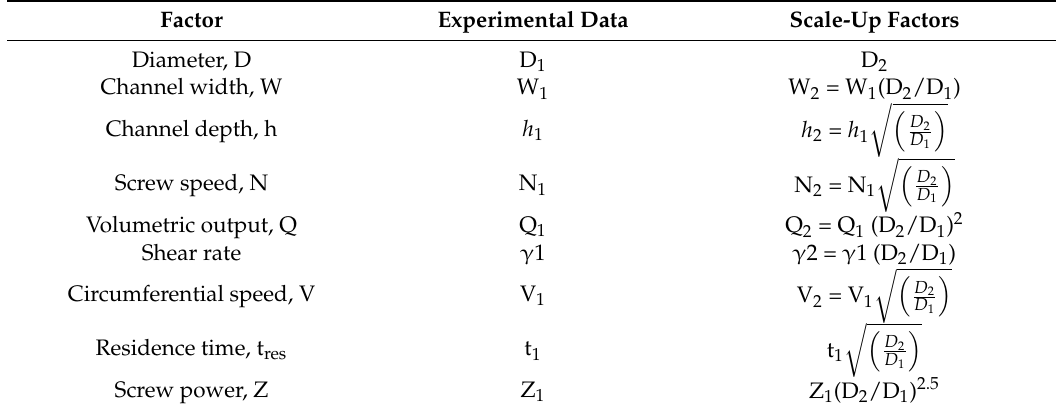
Table 5. Scale-up factors for extrusion [28,29].